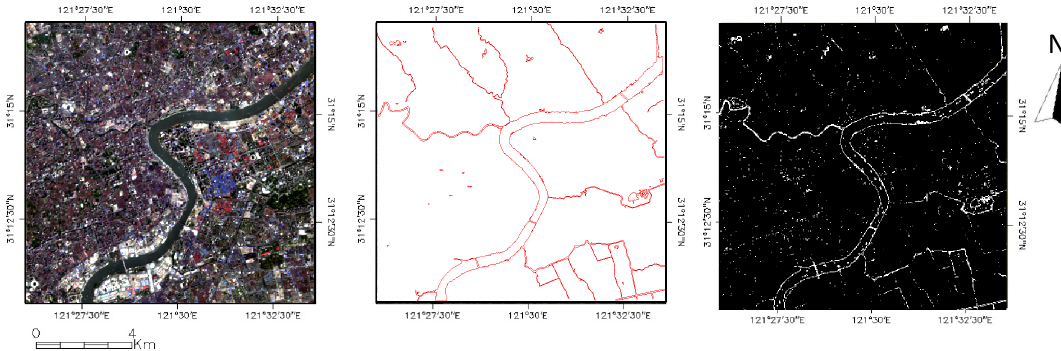
Figure 4. Maps showing the processing of the mixed land-water pixel extraction. ( a ) Landsat OLI true-color composite (RGB: bands 4, 3, 2) image of the Shanghai test site; ( b ) true water boundaries acquired from the high spatial resolution Google Earth TM images; and ( c ) mixed land-water pixels derived from the water